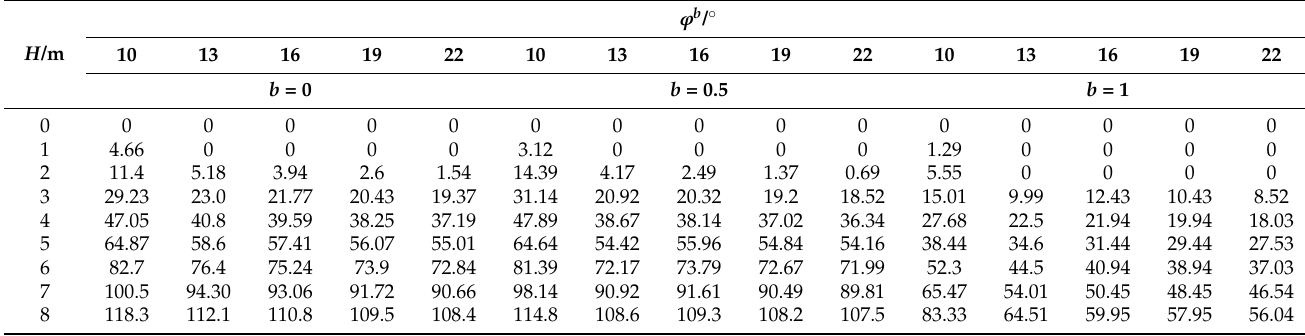
Table 2. Intensity values of Rankine active earth pressure and matric suction related friction an ‐ gles.